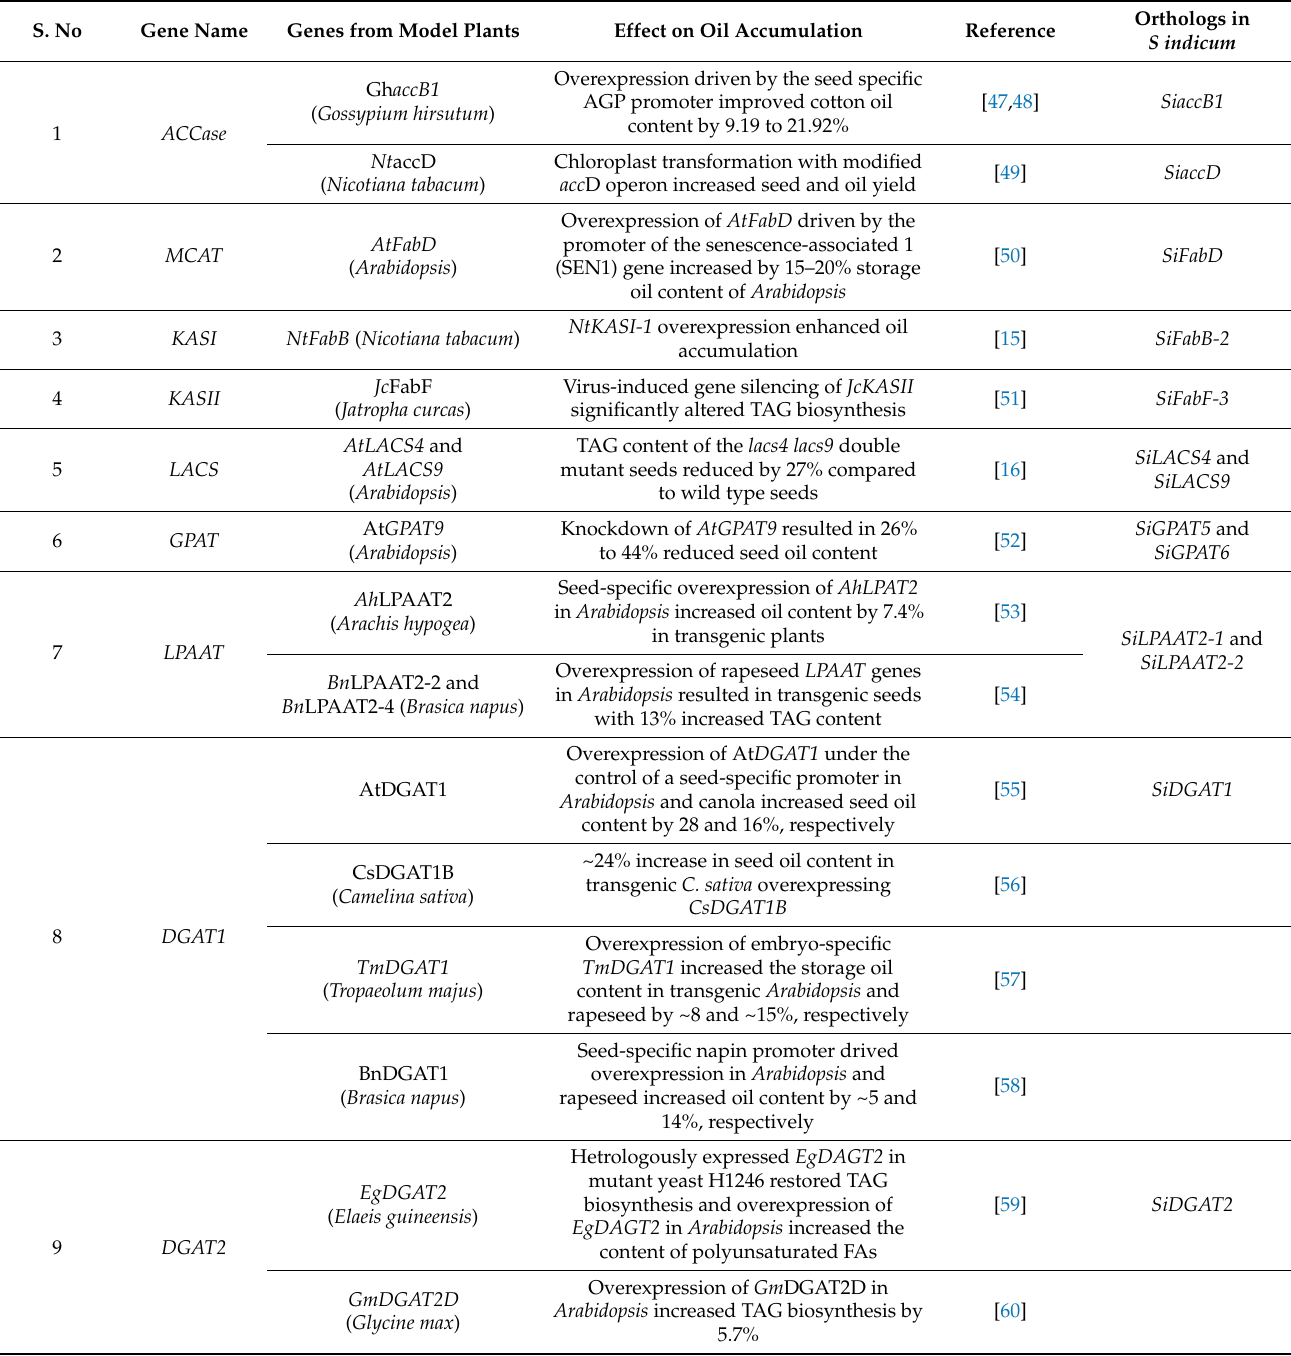
Table 3. List of orthologs in sesame identified from genes reported in model plants as associated with improving oil